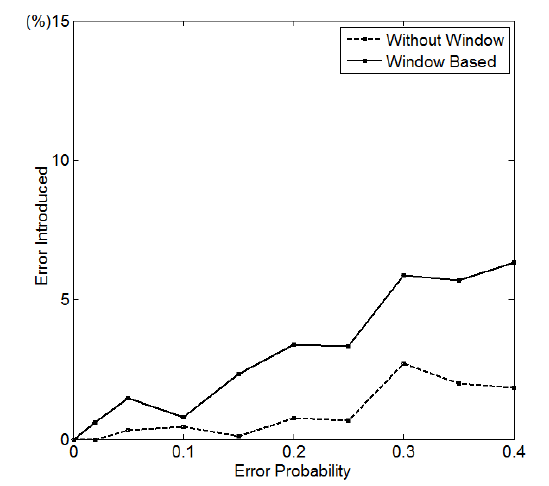
Figure 9. Comparison of With and Without Sliding Window On Probability of Errors Introduced.